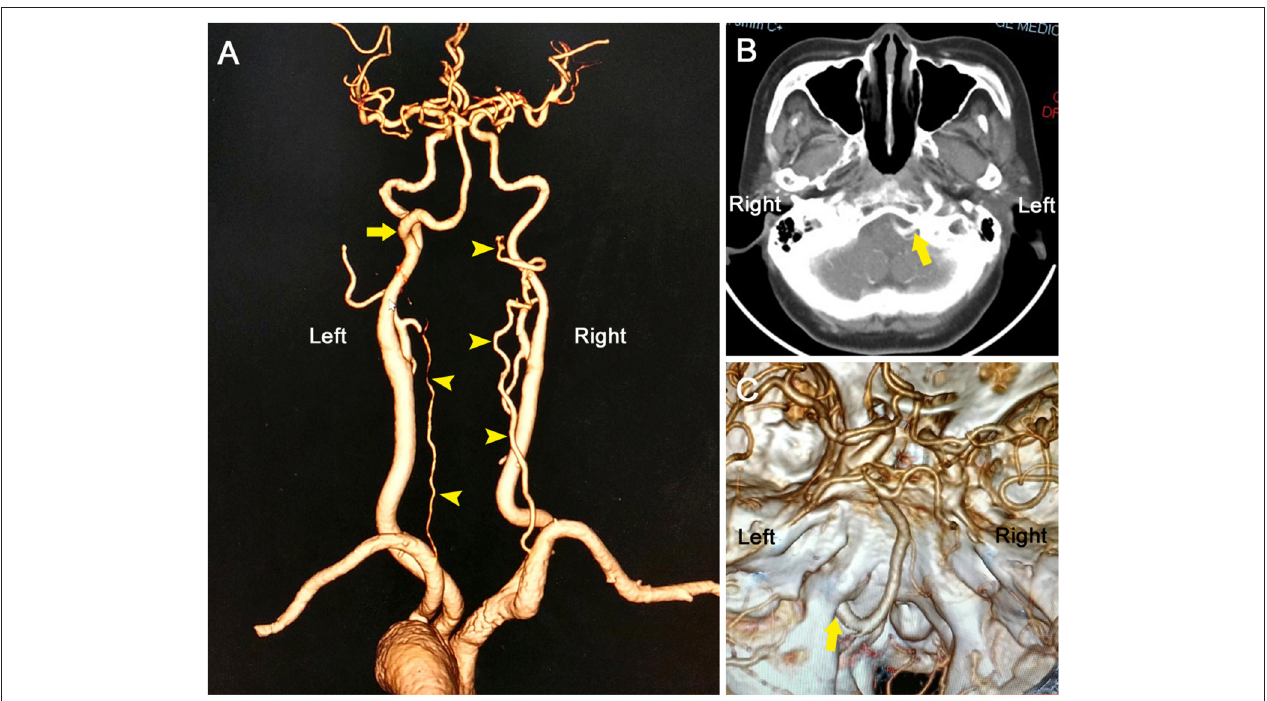
FIGURE 3 | Computed tomography angiography showing an anomalous vessel (A , arrow) arising from the left internal carotid artery and then traveling through the left hypoglossal canal (B,C) , consistent with the diagnosis of persistent hypoglossal artery. Note that bilateral vertebral arteries were hypoplastic (arrowheads), and no posterior communicating arteries were found; therefore, the PHA primarily fed the posterior